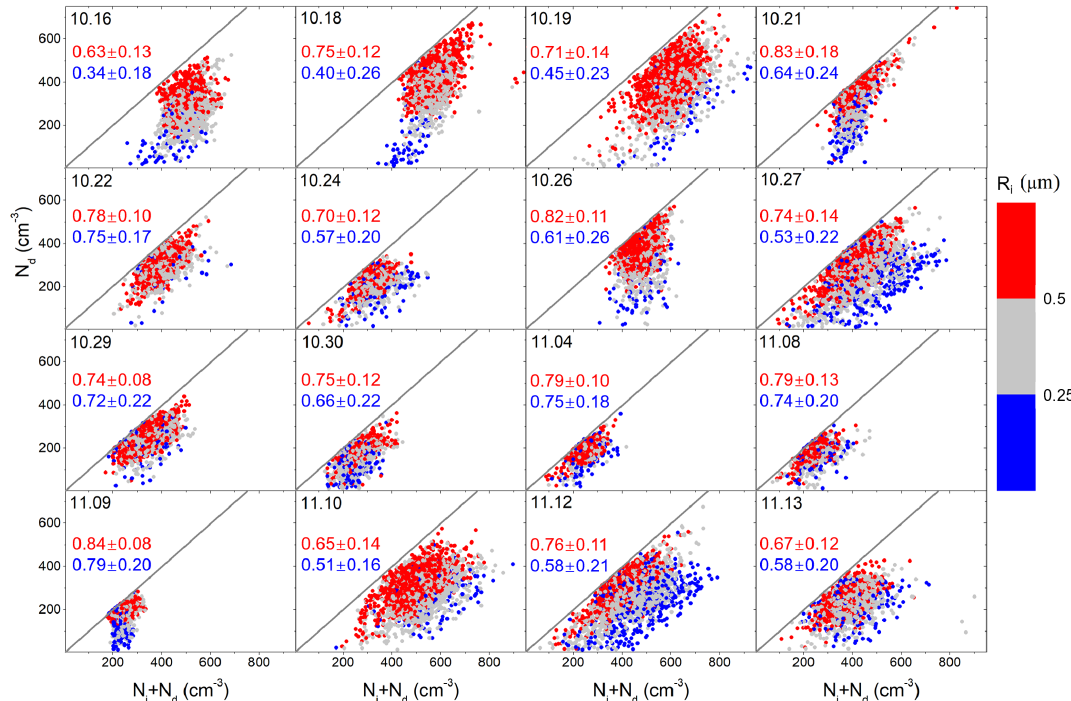
Figure 7. Same as Fig. 6, but the color represents the effective radius of interstitial aerosol ( R i ; µm). The mean and standard deviation of